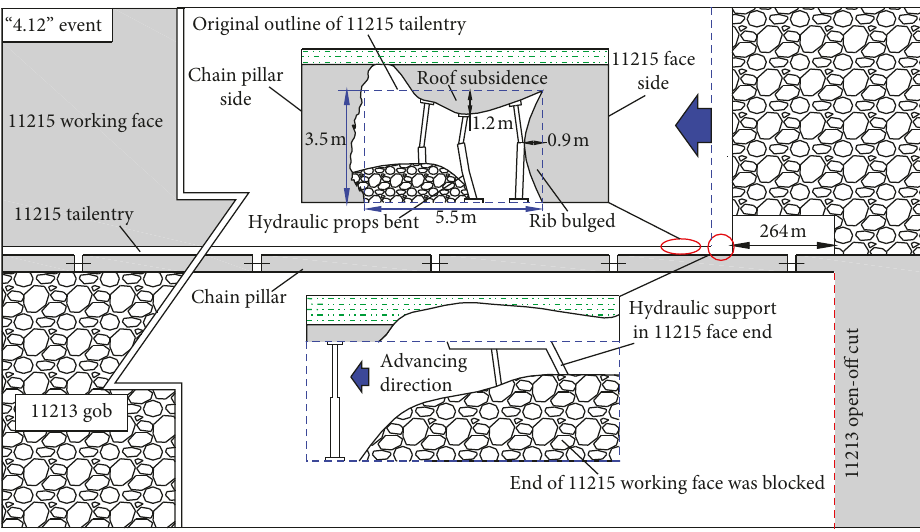
Figure 4: Sketch of the “4.12” event.